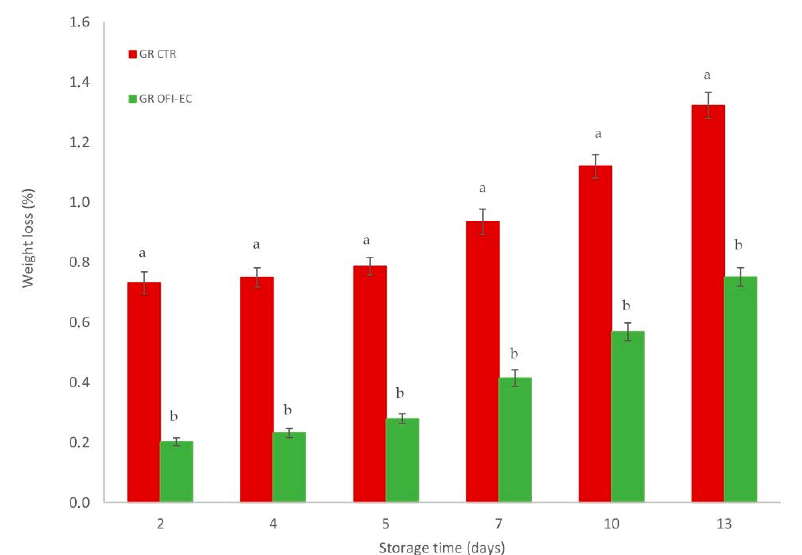
Figure 2. Changes in weight loss (%) in minimally processed Gigante Rossa loquat fruits, untreated fruit (GR CTR), and fruits treated with mucilage (GR OFI-EC) during cold storage (13 days at 5 ◦ C). Different lowercase letters indicate significant differences at p ≤ 0.05 between the treatments on each sampling date. Data are the mean ± SE (Vertical bars represent standard error; n = 5